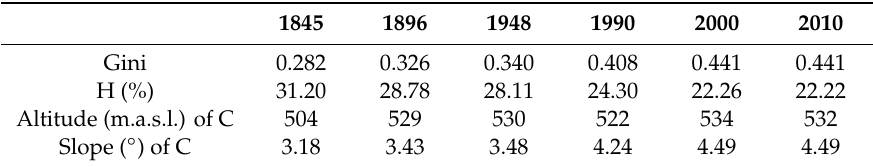
Table 4. Changing distribution of grasslands: Gini, H, average altitude, and slope for the concentrated half of BTUs